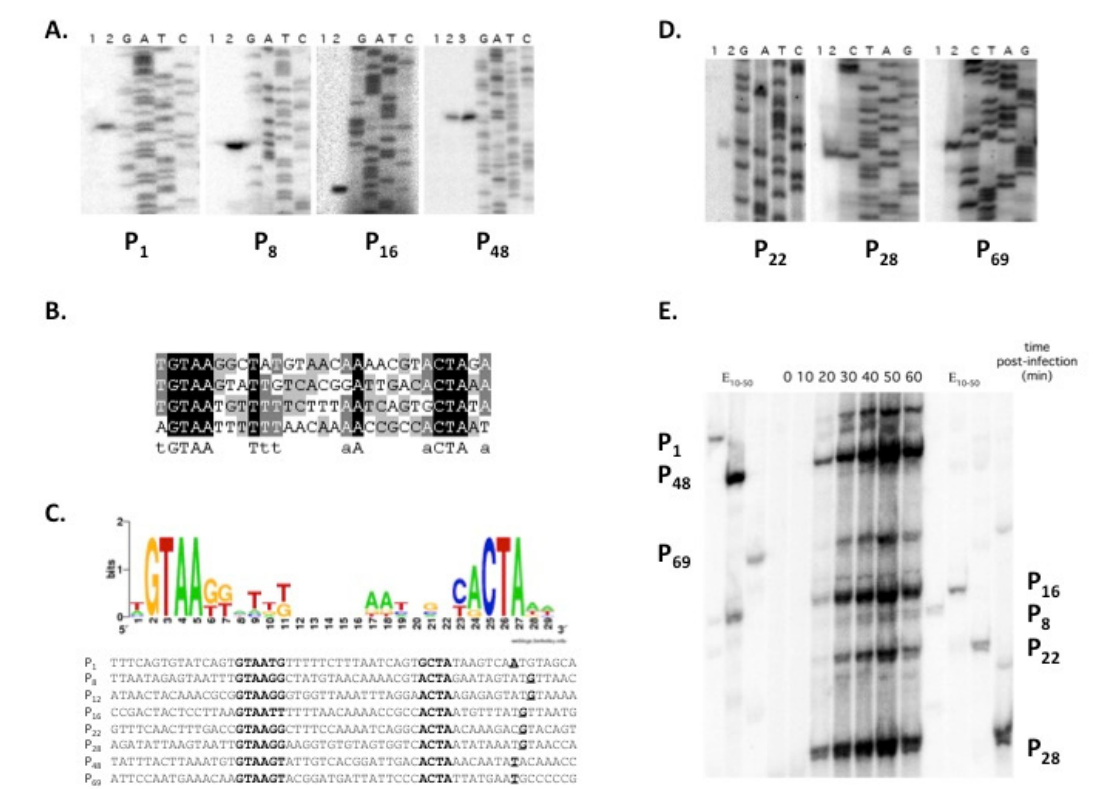
Figure 2. Identification of bacteriophage 7-11 late promoters: ( A ) Results of primer extension analysis using RNA prepared from cells before (lanes 1) or 40 min after (lanes 2) 7-11 infection using primers annealing upstream of 7-11 genes 1 , 8 , 16 and 48 corresponding to phiEco32 genes proximal to its late promoters. Lane 3 for the P 48 panel shows the results of primer extension with RNA synthesized in vitro by the SaPh711_gp47-RNAP holoenzyme. The reaction products were separated in 6% denaturing polyacrylamide gels and visualized using a PhosphorImager. ( B ) The alignment of P 1 , P 8 , P 16 and P 48 promoters validated in panel ( A ). ( C ) A Logo representation of phage 7-11 late promoters. The alignment below shows, in addition to P 1 , P 8 , P 16 and P 48 promoters validated in panel ( A ), promoters retrieved by an additional targeted search using the 7-11 late promoter consensus. Conserved elements are shown in bold typeface. Transcription start points are shown in bold and are underlined. ( D ) Validation of P 22 , P 28 and P 69 promoters predicted bioinformatically in ( C ). See panel ( A ) legend for details. ( E ) Kinetics of accumulation of late transcripts during 7-11 infection. Results of multiplex primer extension analysis of total RNA extracted from phage-infected cells collected at various time points postinfection using primers designed to reveal transcription from indicated late phage promoters. On the left and on the right, products of individual primer extension reactions on RNA pooled from samples from each time point are shown. The reaction products were separated in 6% denaturing polyacrylamide gel and visualized using